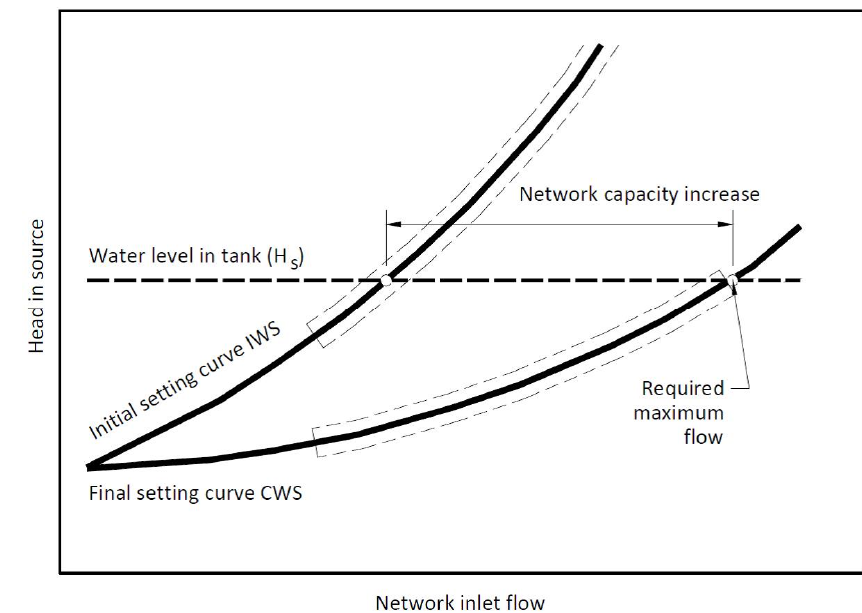
Figure 5. Network capacity increase process.